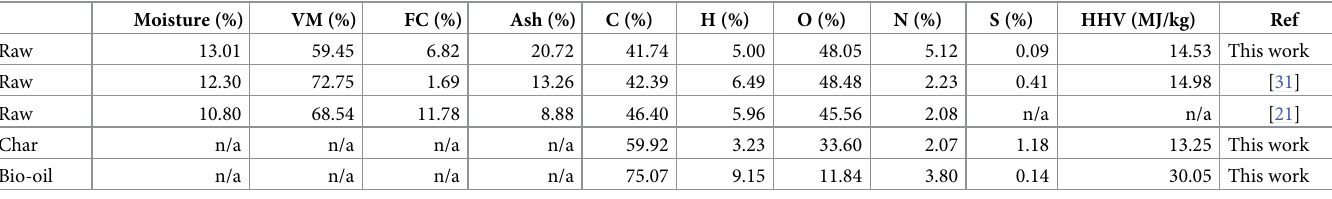
Table 1. Proximate � and ultimate �� analysis results of raw tobacco residues and the main pyrolysis products. Moisture (%) Raw